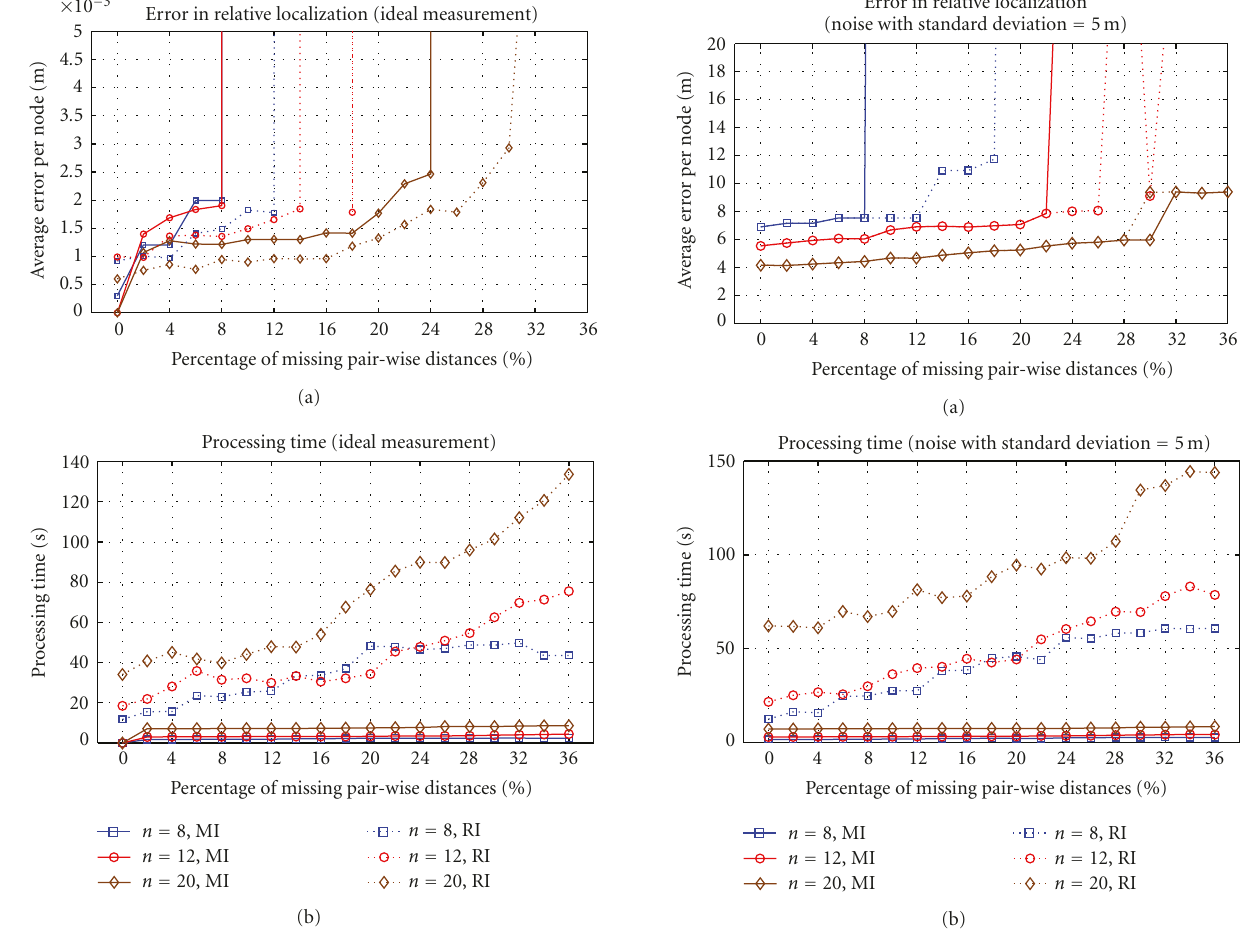
Figure 4: (a) Error performance; (b) processing time versus percentage of missing pairwise distances using distances with added 0 mean and 5m standard deviation Gaussian